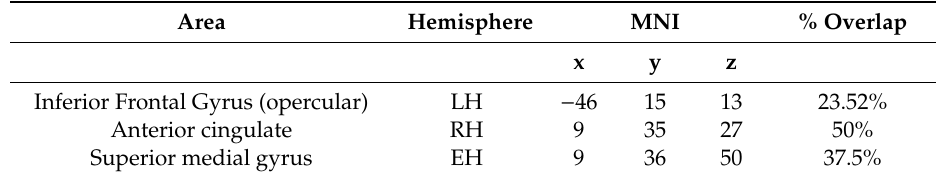
Figure 2. Overlaps of lesion masks of patients with ( A ) LH iLGG, and ( B ) RH ILGG at cortical (first row) and subcortical level (second row). Table 5. Montreal Neurological Institute (MNI) coordinates of the maximum lesion volumes of interest (VOIs)